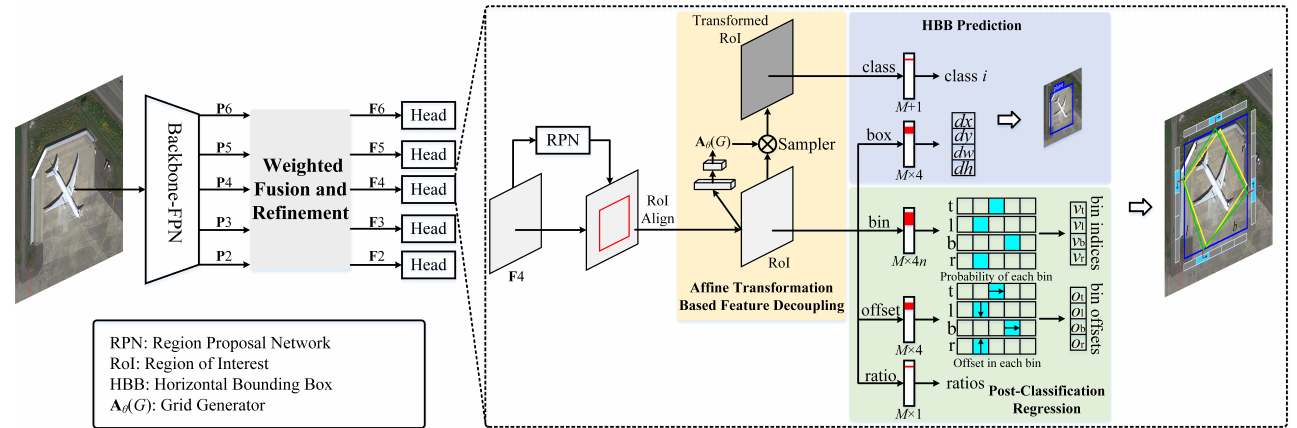
Figure 1. Illustration of our method. On top of Faster R-CNN, we introduce a weighted fusion and refinement (WFR) module, an affine transformation-based feature decoupling (ATFD) module, and a post-classification regression (PCR) module. WFR receives the pyramidal features P ∗ and derives an enhanced feature pyramid F ∗ . After obtaining the RoI features, ATFD performs task-specific feature decoupling for the subsequent classification and regression. The regression is split into the prediction of regular HBB and that of orientation-relevant parameters responsible for converting the predicted HBB into quadrilateral bounding boxes. PCR facilitates the prediction of orientation- relevant parameters. M The number of classes is in the HBB prediction part. n The number of bins is in the post-classification regression